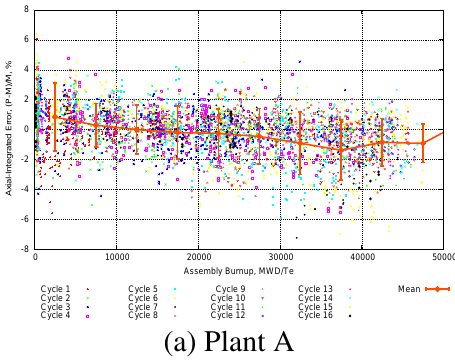
Figure 6: Radial Powershape error as a function of Assembly